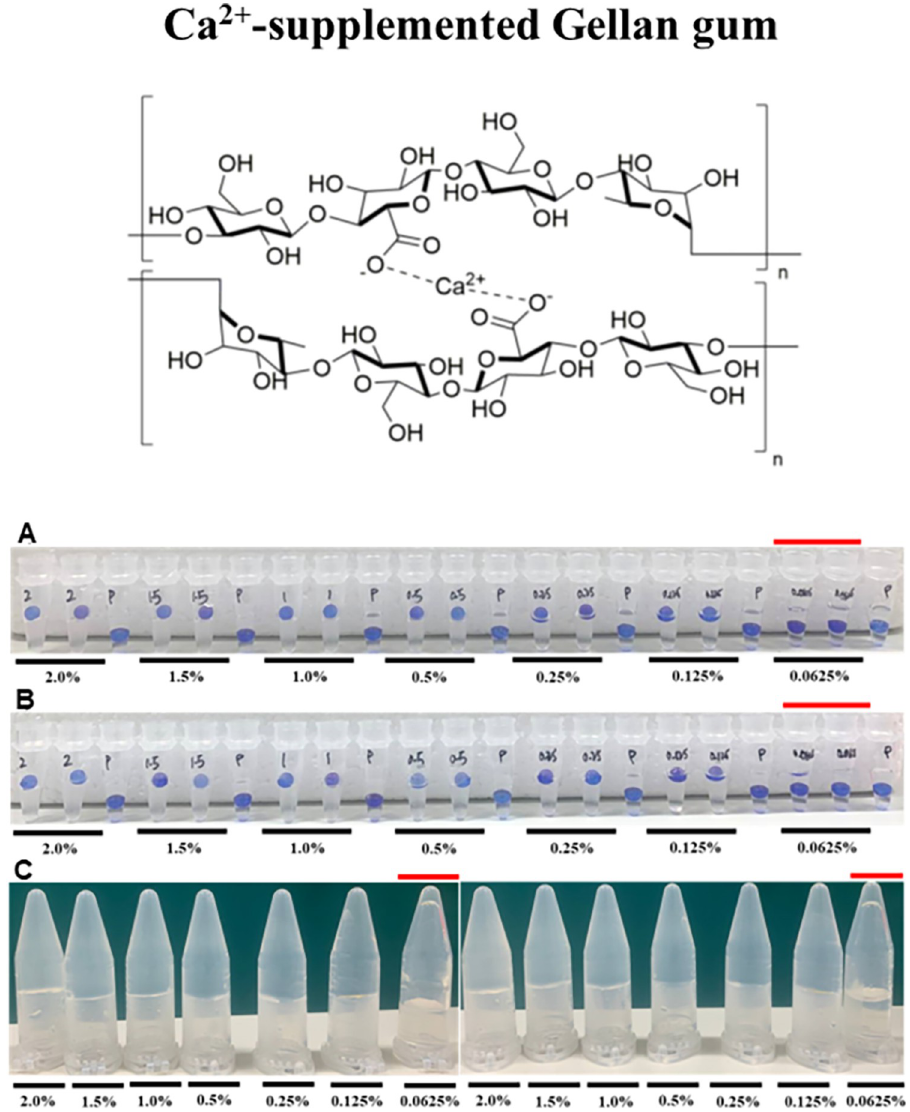
Fig 4. Determining the minimum gelling concentration of calcium-supplemented low acyl gellan gum via the floating sphere and inversion assays. Representation of gelation results of calcium-supplemented low acyl gellan gum in (a) Thermocycler–Floating Sphere Assay; (b) Water bath–Floating Sphere Assay and (c) Water bath–Inversion Assay. Red line indicates the concentrations below the critical gelling concentration. A minimum of three biological replicates was performed. Results from two additional replicates are presented in S4 Fig.